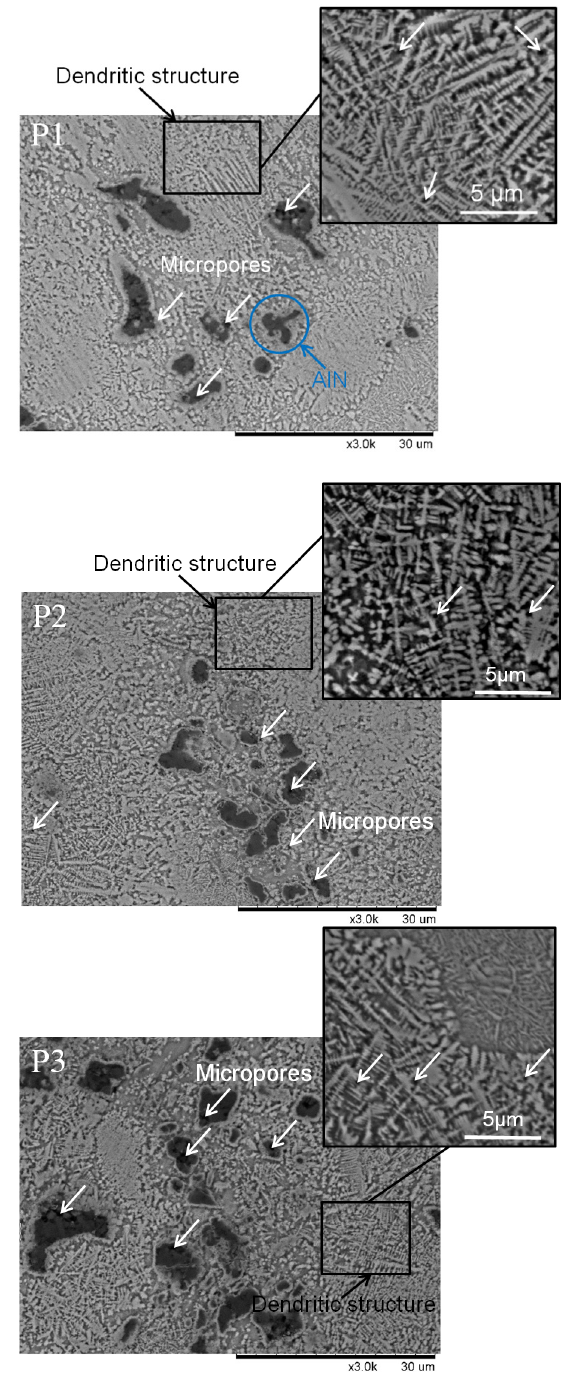
Figure 4. Microstructures of P1 , P2, and P3 samples etched with Kroll’s reagent. (Micrographs from Scanning Electron Microscope (SEM) in the backscattered electrons (BSE) mode).